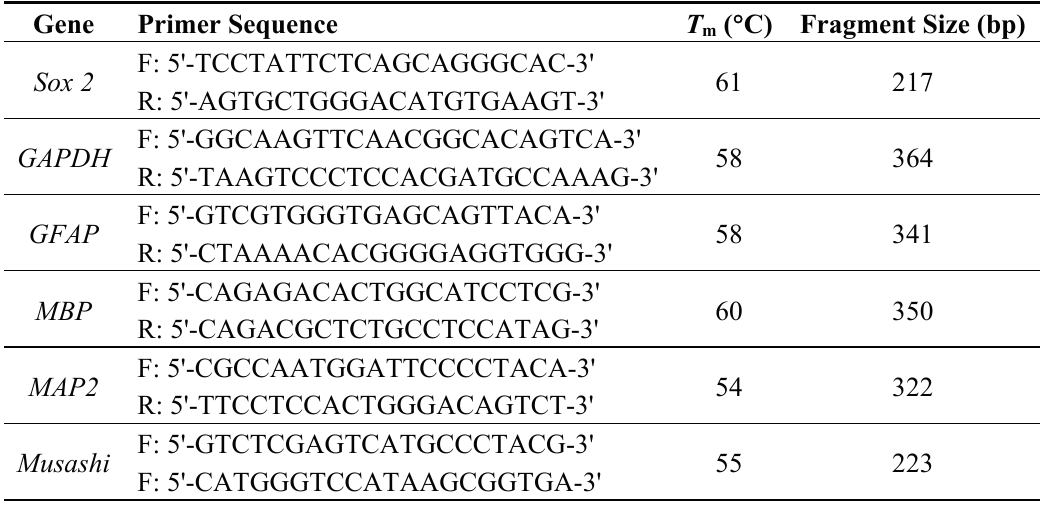
Table 1. Primer sequences used in PCR